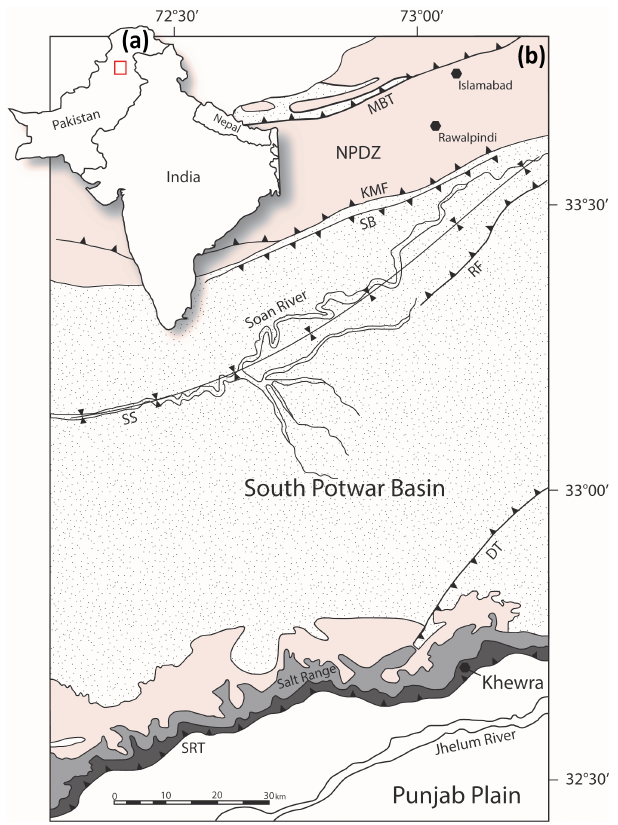
Figure 1. (a) Location map of the study area. (b) Geological map of the eastern Salt Range and Potwar Plateau. MBT: Main Bound- ary Thrust, NPDZ: North Potwar Deformation Zone, KMF: Khari Murat Fault, SB: Soan Backthrust, SS: Soan Syncline, RF: Riwat Fault, DT: Domeli Thrust, SRT: Salt Range Thrust. The colour shad- ing references the geological groups and formations seen in Fig. 2 (after Richards et al.,